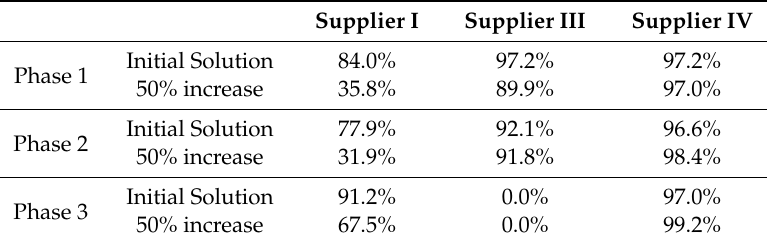
Table 5. Level of utilization of suppliers’